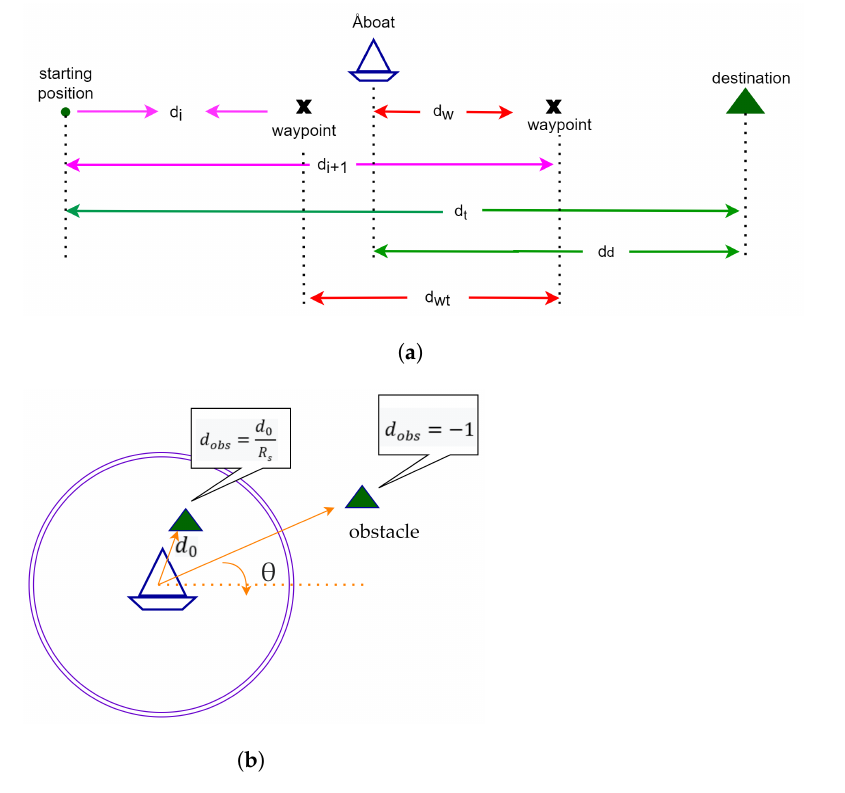
Figure 4. Distance of Åboat from the obstacles, waypoints and destination. ( a ) Distance from destination and waypoints; ( b ) Distance from